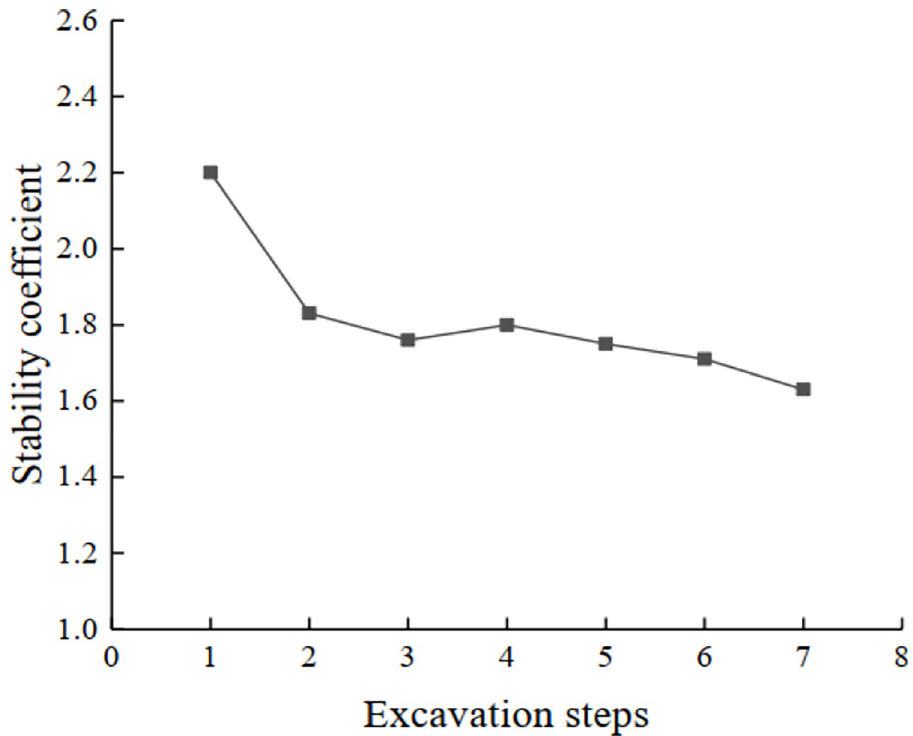
Fig 13. Variation curve of slope stability coefficient.